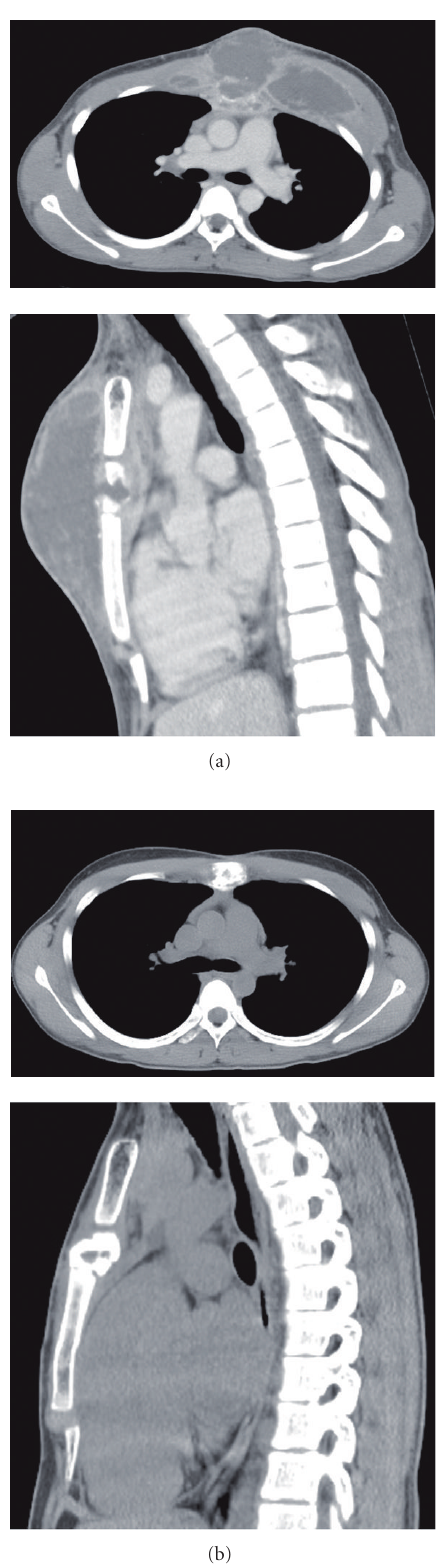
Figure 2: (a) Chest CT scan (upper) and reconstructed sagittal image (lower) revealed a sternal fracture and massive abscess formation. (b) Follow-up CT revealed the disappearance of fluid